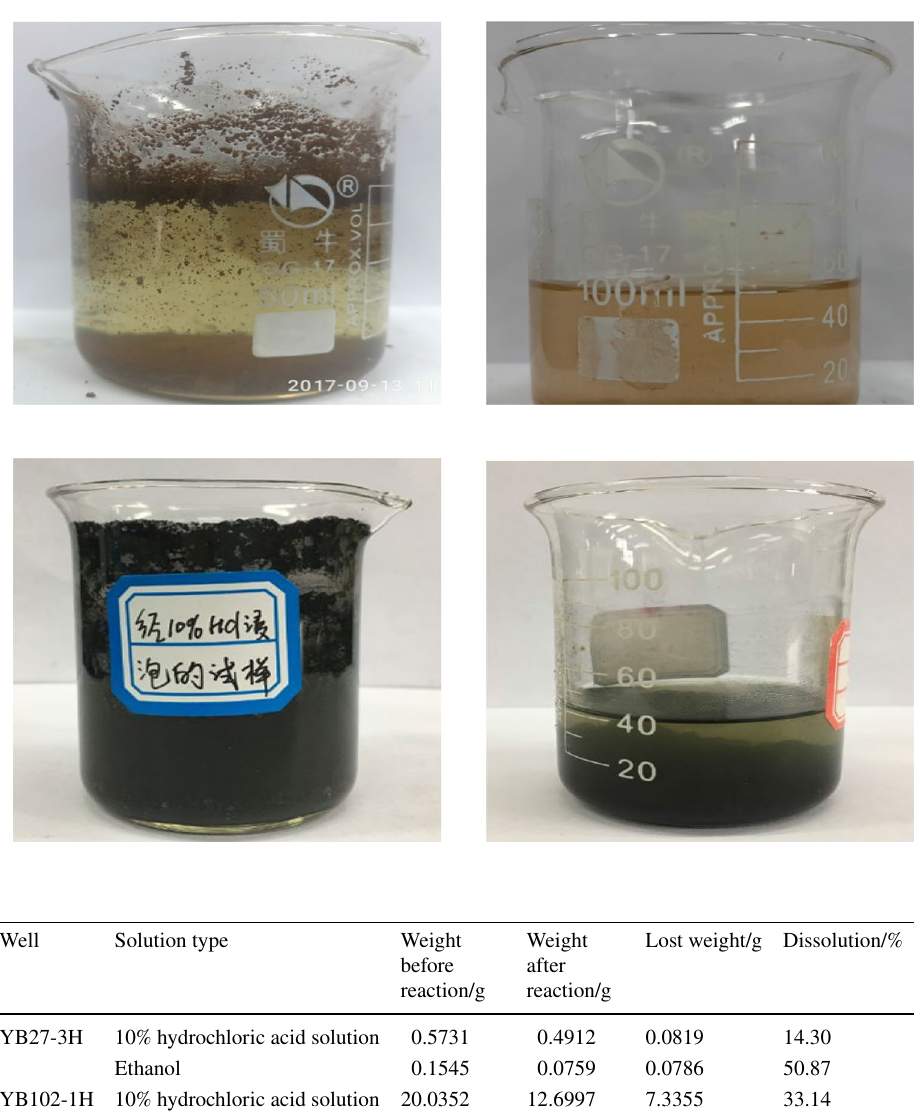
Fig. 7 Reaction results of the blockage sample of YB27-3H in 10% hydrochloric acid solution and ethanol